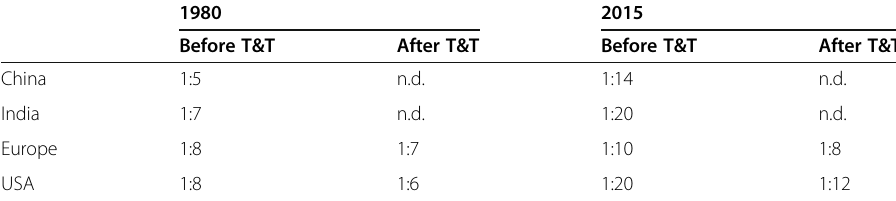
Table 5 The bottom half and the top 10%. Income ratios in China, India, Europe, and the USA, 1980 – 2015. Before and after taxes and transfers (T&T) 1980 2015 Before T&T After T&T Before T&T After T&T China 1:5 n.d. 1:14 n.d. India 1:7 n.d. 1:20 n.d. Europe 1:8 1:7 USA 1:8 Europe is all Europe excl. Russia, Ukraine, and Belarus. Sources: China (1978 and 2015) and India: World Inequality Database, www.wid.world/country; Europe and USA: Blanchet et al. 2019: